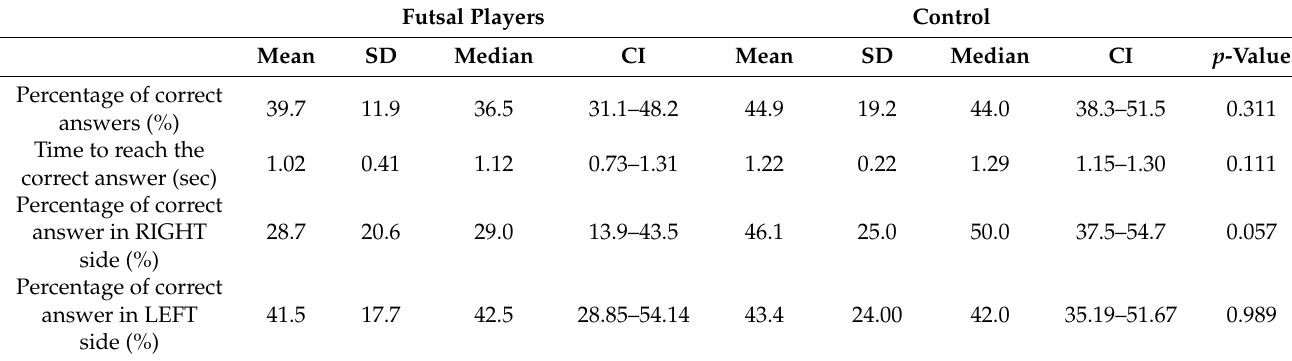
Table 4. Results of Peripheral Response PAT